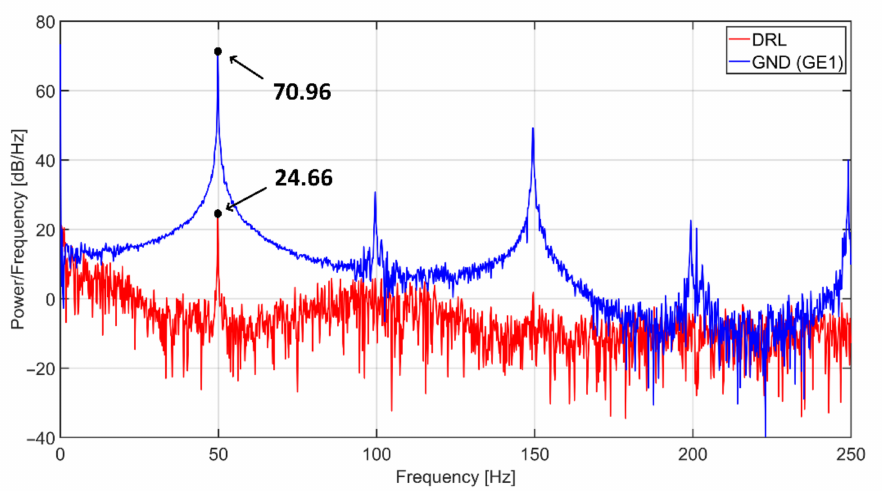
Figure 20. Power spectral densities of capacitive ECG signal using grounding ( blue ) and DRL ( red )